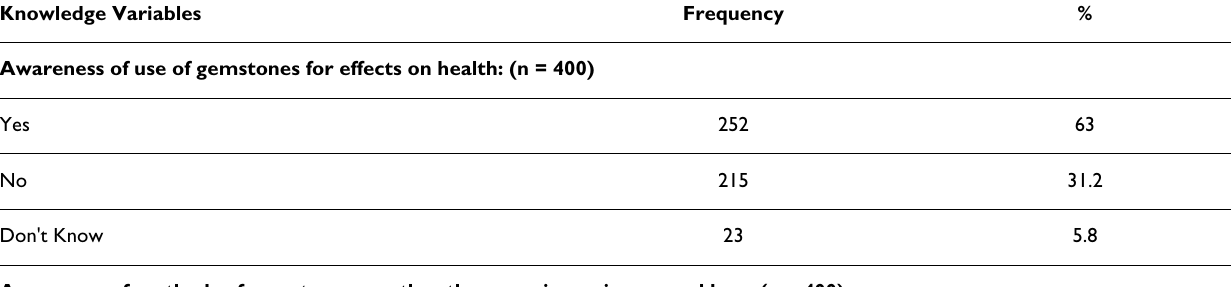
Table 2: Knowledge Variables Knowledge Variables